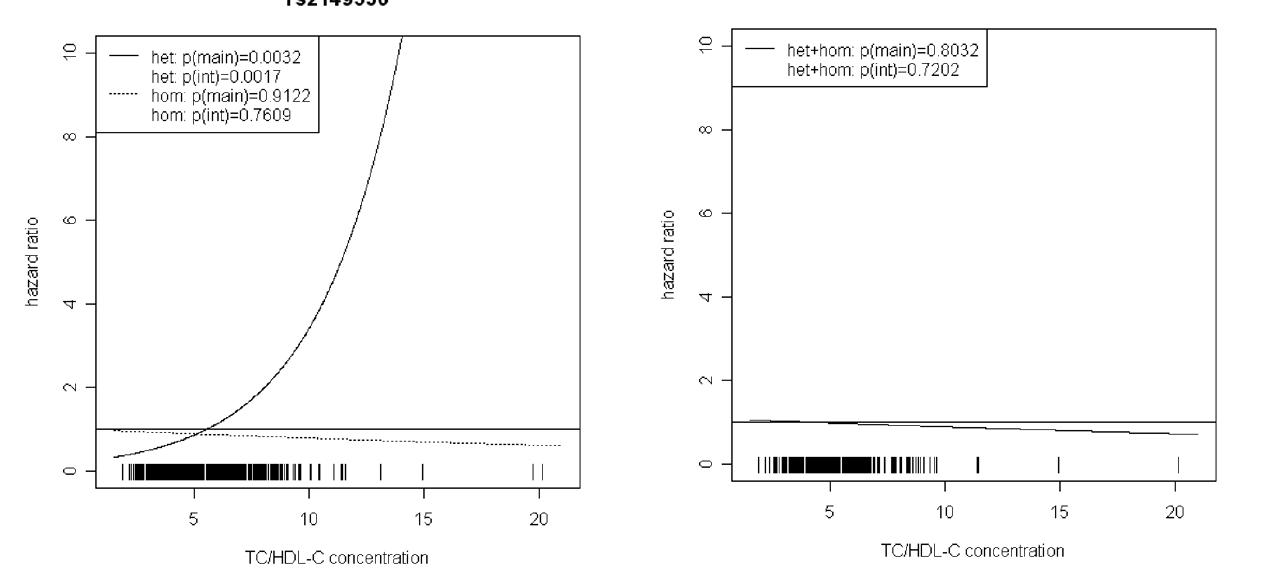
Hazard ratios of incident type 2 diabetes related to the respective TC/HDL-C concentration in men for rs2149356 Figure 5 represent subjects who are homozygote for the minor allele, while contin- uous lines show heterozygotes. Small bars at the x-axis indicate TC/HDL- C concentrations of patients with at least one copy of the minor allele.